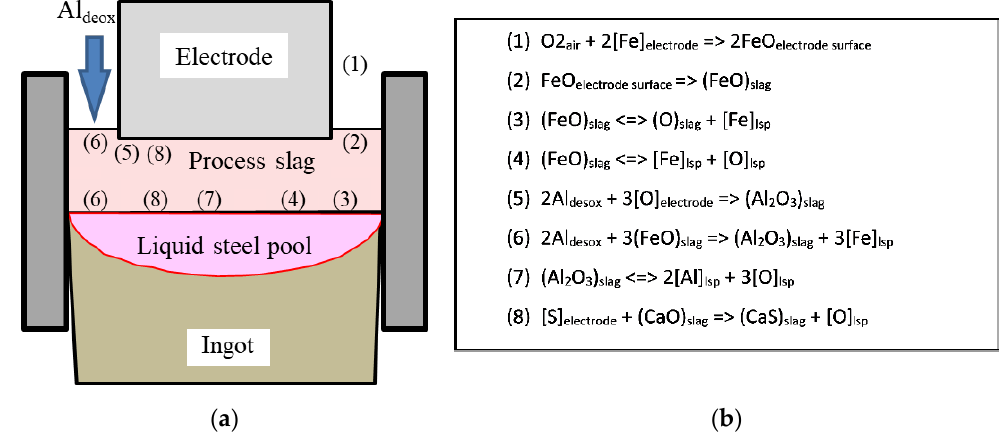
Figure 9. ( a ) Schematic illustration of the mechanisms of oxygen transfers and Al deoxidation in ESR process (lsp-liquid steel pool). ( b ) Numbering of reactions in the figure is given according to [10].